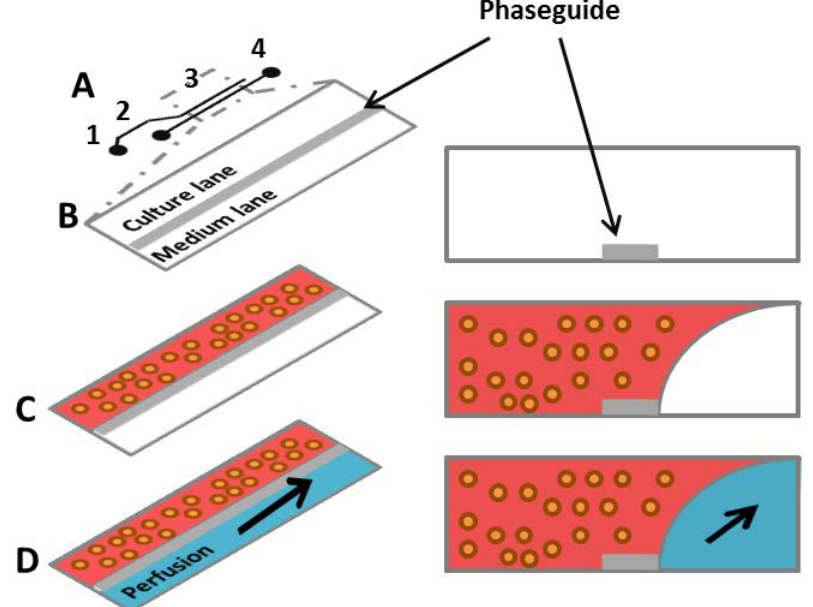
Figure 5. ( A ) A single 2-lane bioreactor scheme composed of: 1—a gel inlet; 2—a perfusion inlet; 3—an optical readout window; 4—a perfusion outlet; ( B ) the readout window and its cross section (horizintal view); a phaseguide separates a 2-lane chamber and allows to selective gel patterning; ( C ) melted gel with cells is loaded and selectively patterned by the phaseguide; ( D ) after gelation the medium is provided in the perfusion lane and gravitational leveling leads to perfusion between the perfusion inlet and the perfusion outlet wells [78].